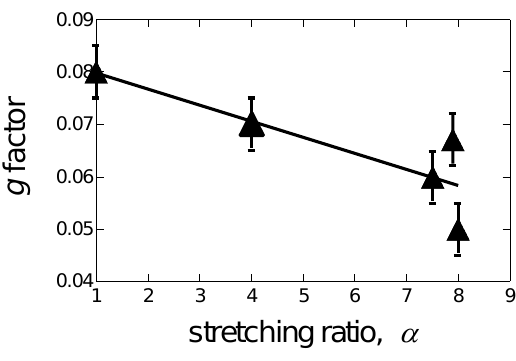
Figure 3. Variation of the g -factor as a function of the stretching ratio (  ), evaluated from the model fitting of the SAXS profiles shown in Figure